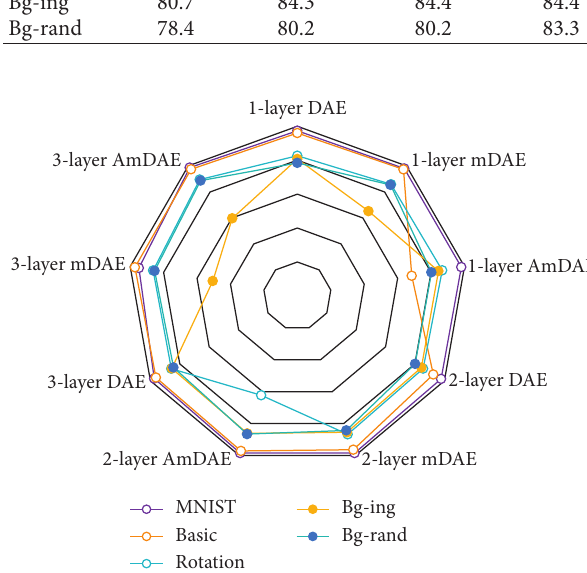
Figure 4: Average recognition accuracy